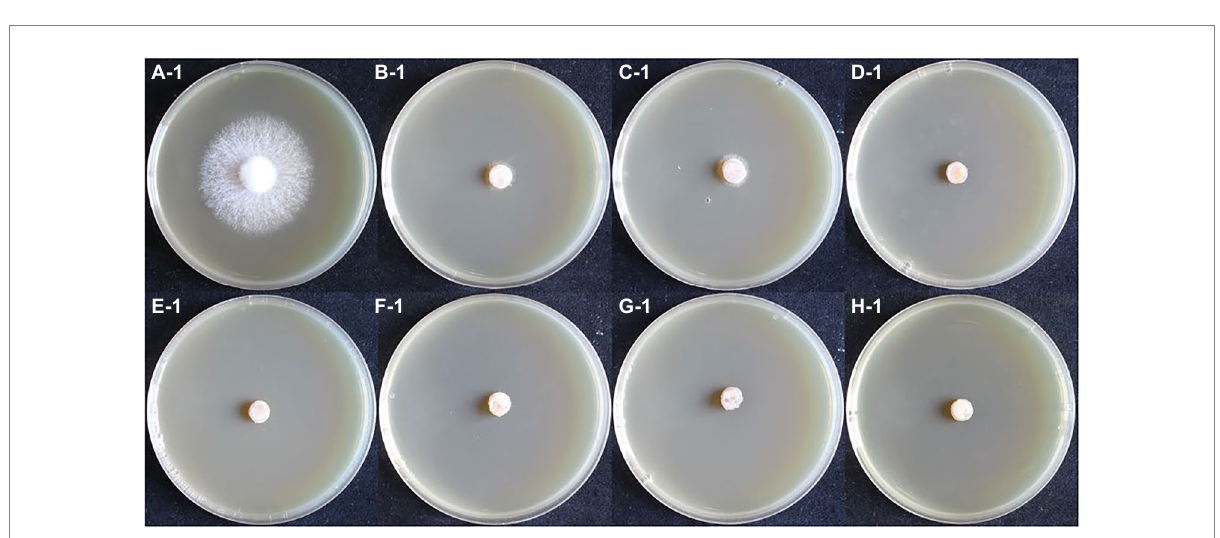
FIGURE 2 The growth of dikaryotic strain in different hygromycin concentrations. (A–H) The concentrations of hygromycin were 0, 6, 8, 10, 12, 14, 16, 18 μ g/ ml, respectively.